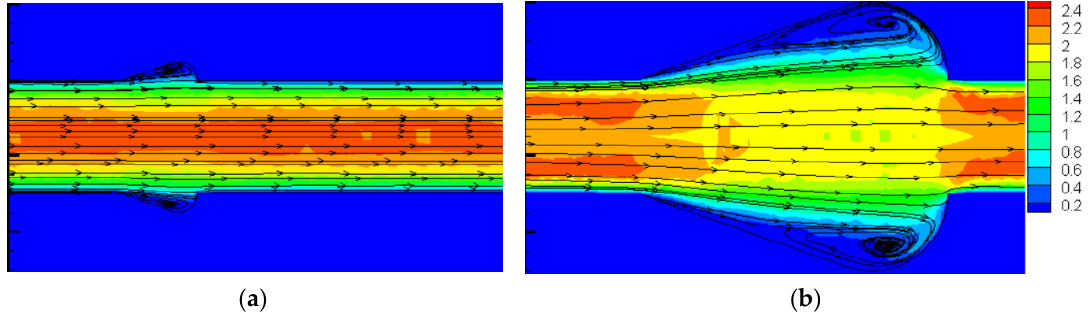
Figure 18. Velocity and streamline distribution in cavities for Re = 500 with di ff erent β . ( a ) β = 1.33 Figure 18. velocity and streamline distribution in cavities for 𝑅𝑒 = 500 with different 𝛽 . ( a ) 𝛽 = 1.33 ( b ) 𝛽 = 2.33 . ( b ) β =